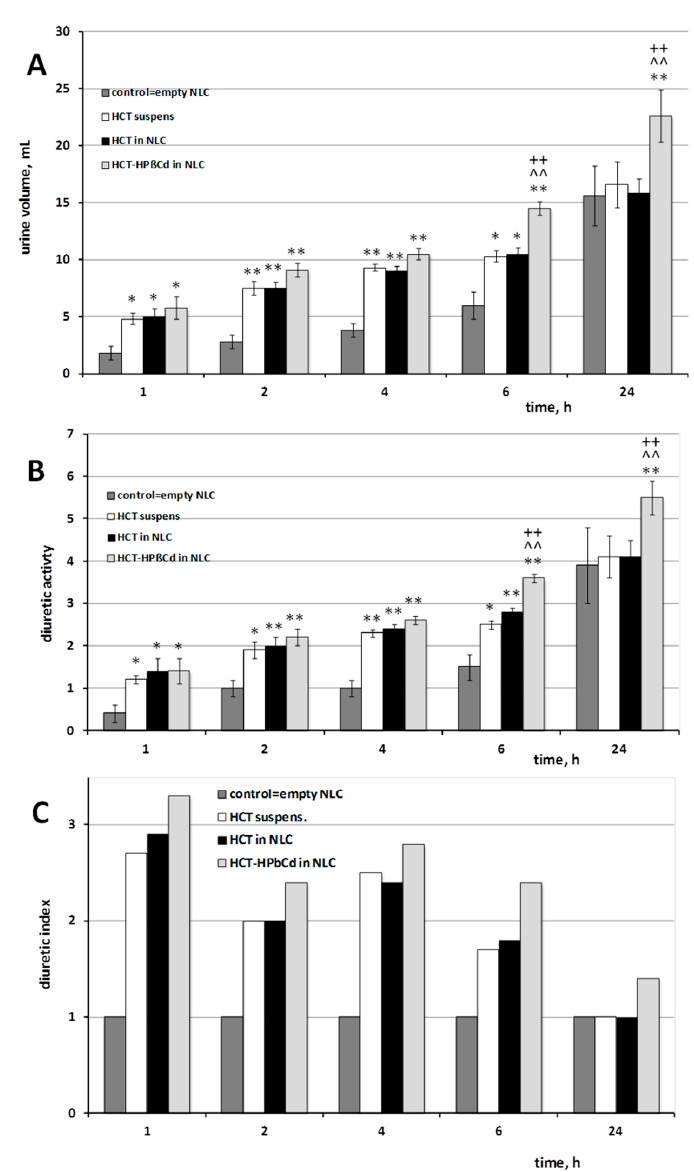
Figure 4 . Diuretic activity in rats, expressed as volume of excreted urine ( A ), ml/100 g body weight ( B ) and diuretic index ( C ) after oral administration (10 mg kg − 1 ) of Hydrochlorothiazide (HCT) as aqueous suspension or as GR product with HP β CD loaded into Tween®80-based NLC, compared to control group treated with a same volume of physiological saline (0.9% NaCl). * P <0.05 and ** P <0.01 vs. control group; ^^ P <0.01 vs. HCT suspension; ++ P <0.01 vs. HCT-loaded NLC.